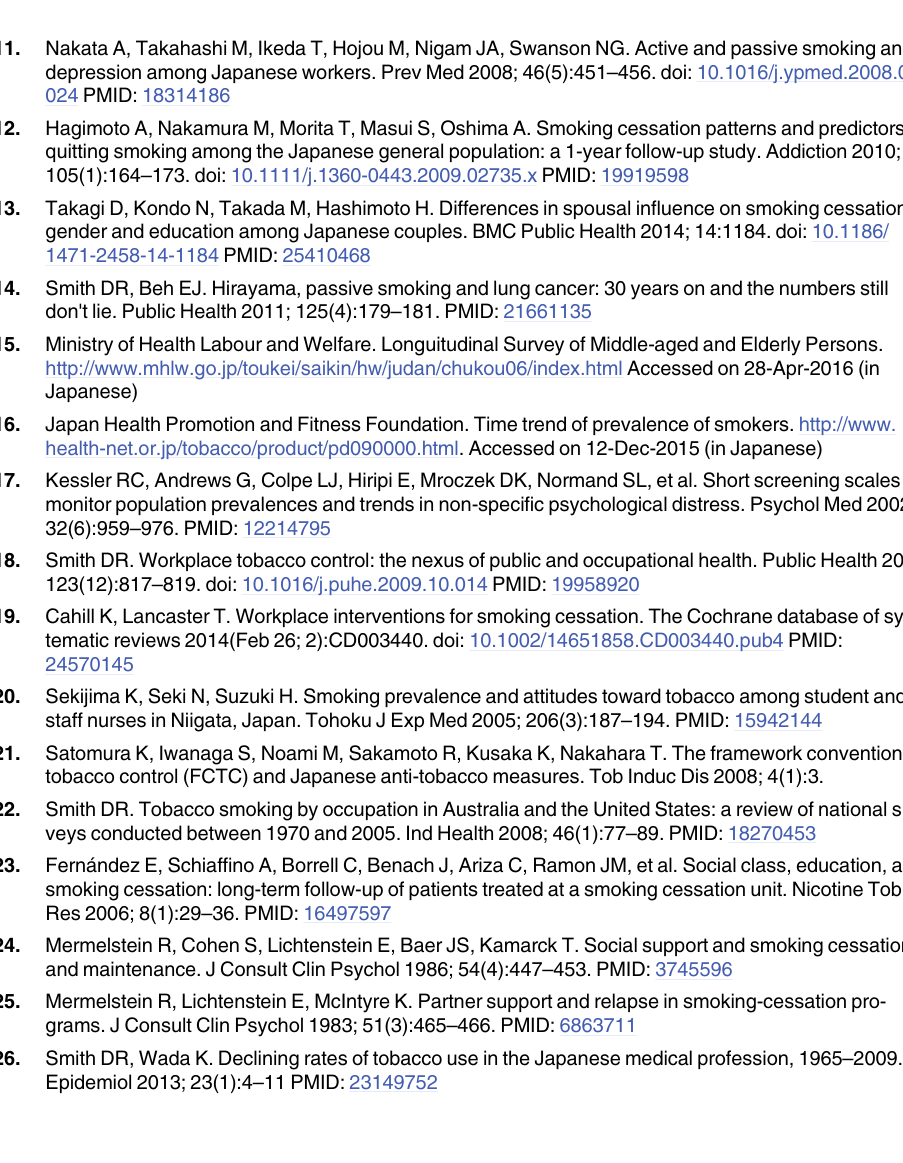
PLOS ONE | DOI:10.1371/journal.pone.0155151 May 10,